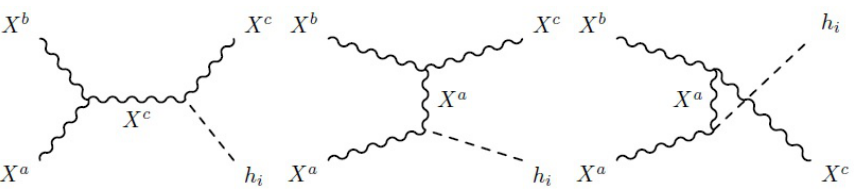
Figure 14 . Feynman diagrams for DM annihilation to scalars, with { h j , h k } = { H, S } .